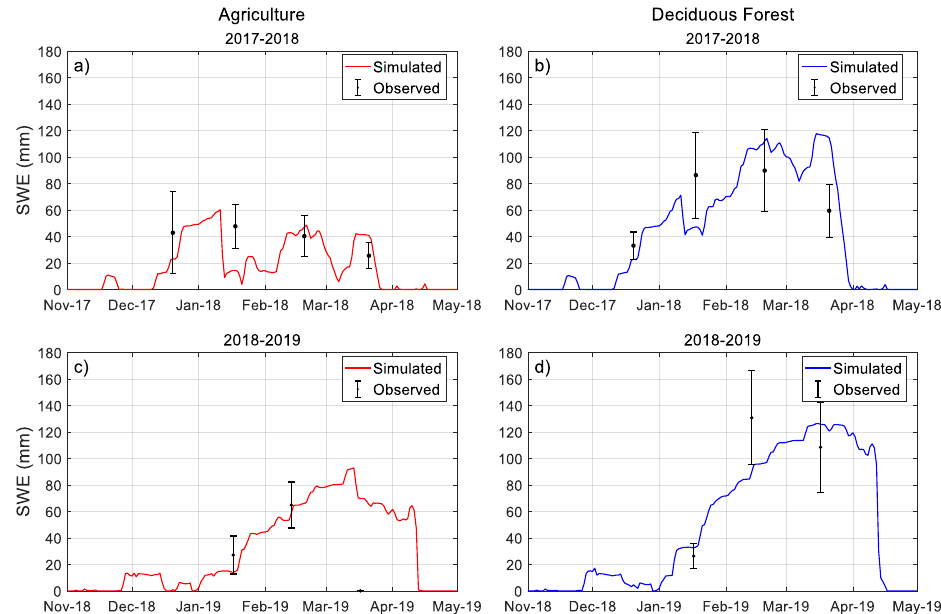
Figure 3. Comparisons of simulated and observed SWE for ( a , c ) agriculture and ( b , d ) deciduous forest for the winters of 2017–2018 and 2018–2019, respectively. Error bars represent the standard deviation of SWE.